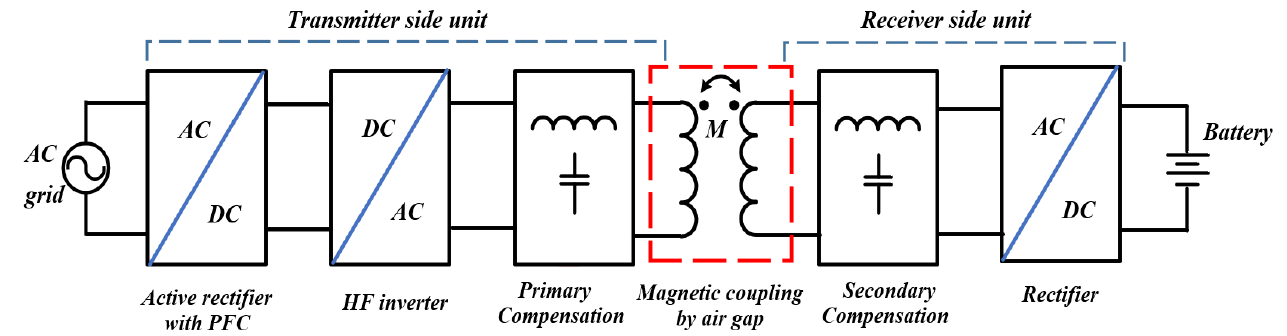
Figure 1. Block diagram of inductive power transfer for electric mobility systems.